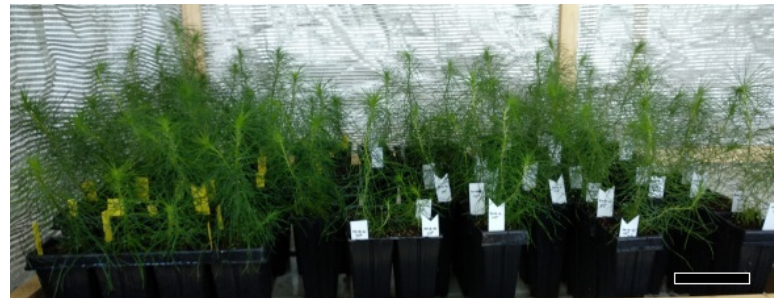
Figure 2. Pinus radiata D.Don plantlets obtained from embryonal masses maturated at high temperatures during the hardening stage in the greenhouse, bar = 8 cm .